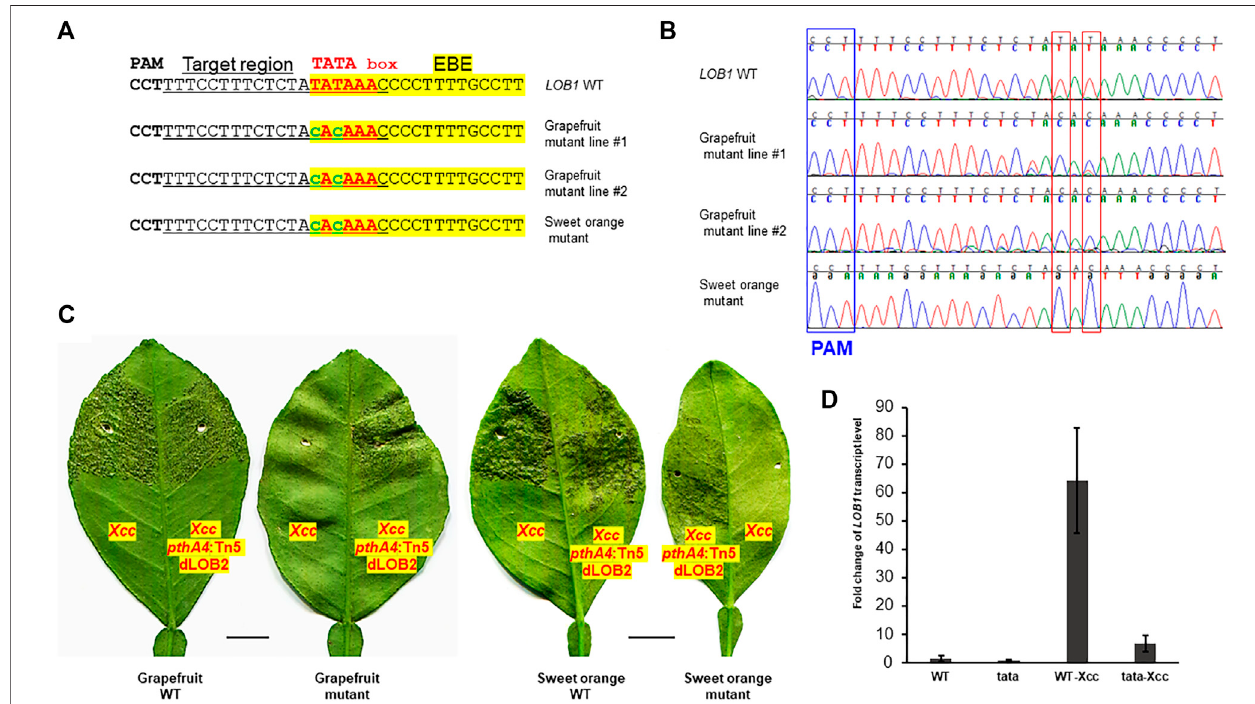
FIGURE 2 | TATA-edited grapefruit ( Citrus paradise ) and sweet orange ( Citrus sinensis ) are resistant to the canker pathogen Xanthomonas citri subsp. citri ( Xcc ). (A) Edition of the TATA box into CACA in stable transgenic grapefruit and sweet orange. Underlined nucleotides were selected for gRNA design (gRNA: GTTTATATA GAGAAAGGAAA); EBE, Xanthomonas TAL effector PthA4 binding element, highlighted with yellow; TATA box, in red font; edited sequences, in lower case with green font. (B) Chromatograms for (A) . Mutation sites are indicated within red rectangles. (C) Inoculation of WT and TATA-edited mutant plants with Xcc or Xcc pthA4 : Tn5 dLOB2 inthe indicated areas ofleaves. XccpthA4 :Tn5 dLOB2,an XccpthA4 mutant strain carryingadesigner TAL effectordLOB2for theinduction ofcitrus LOB2 expression to cause canker symptoms. Xcc pthA4 :Tn5 dLOB2 was used as control. Scale bar, 1 cm. (D) RT-qPCR analyses of CsLOB1 relative expression in leaf samples collected at 48 h post inoculation with Xcc (10 8 CFU/ml). Each treatment has three biological replicates. All expression levels were normalized to the WT. The GAPDH gene was used as an endogenous control. WT: wild type grapefruit plant. tata: TATA-edited grapefruit